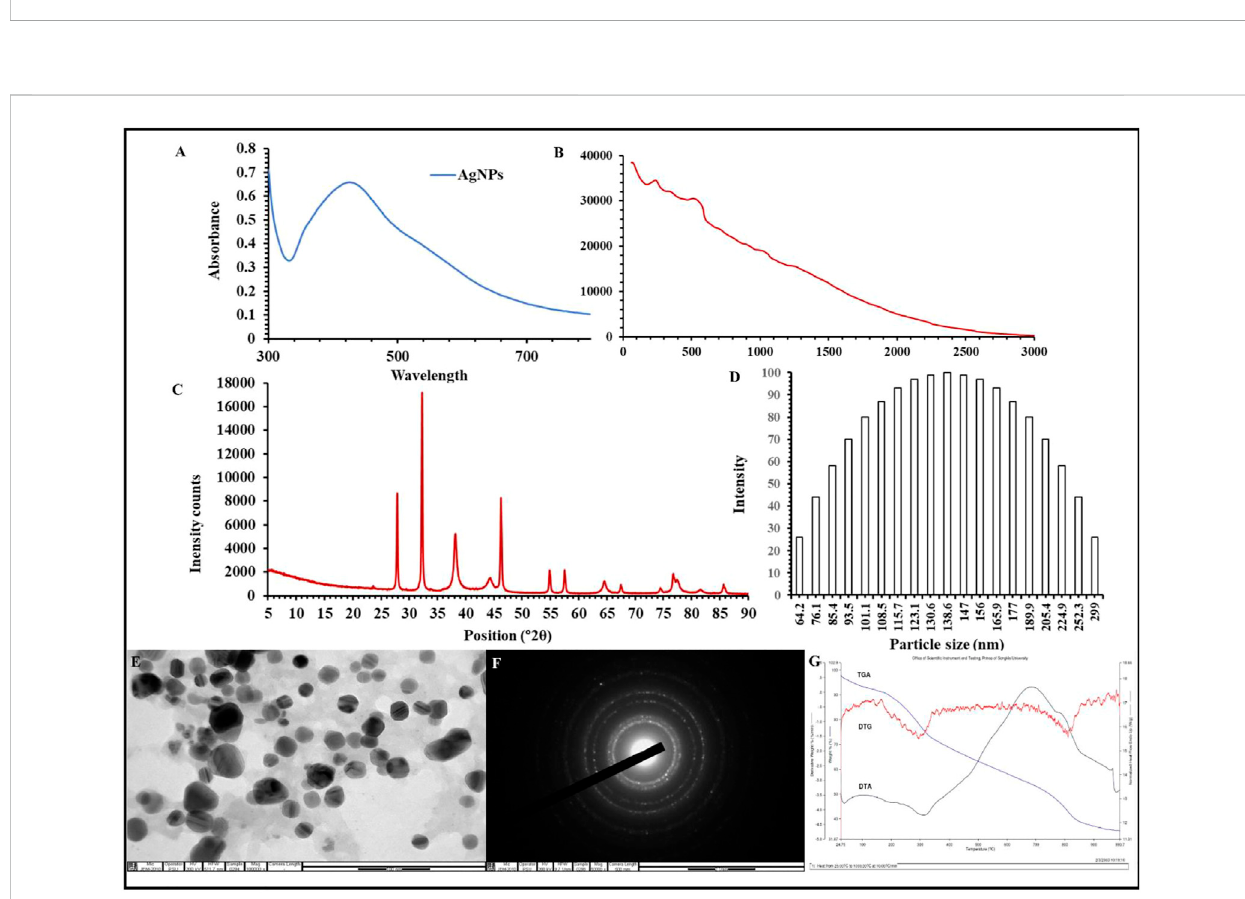
FIGURE 2 Different techniques are used to characterize metallic nanoparticle ’ s UV-vis spectra (A) , Raman spectra (B) , X-ray diffraction spectra (C) , dynamic light scattering (D) , transmission electron microscopy (E, F) , and thermogravimetric analysis (G) . Reproduced with permission (Singh et al., 2022a). Copyright 2022,